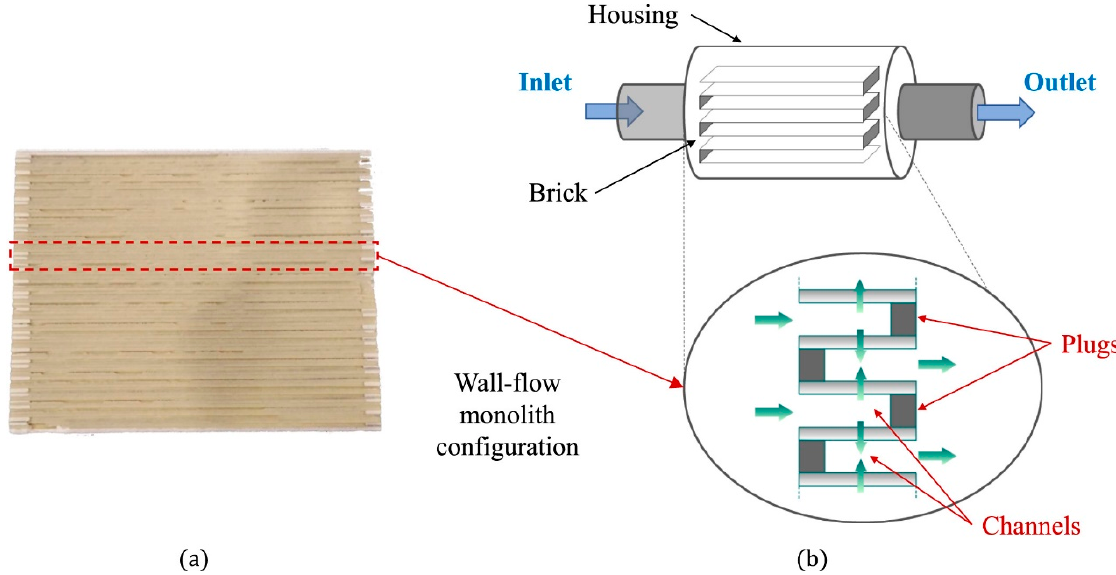
Figure 14. Working principle of GPF: ( a ) Wall-flow monolith structure; ( b ) Channel structure [171].